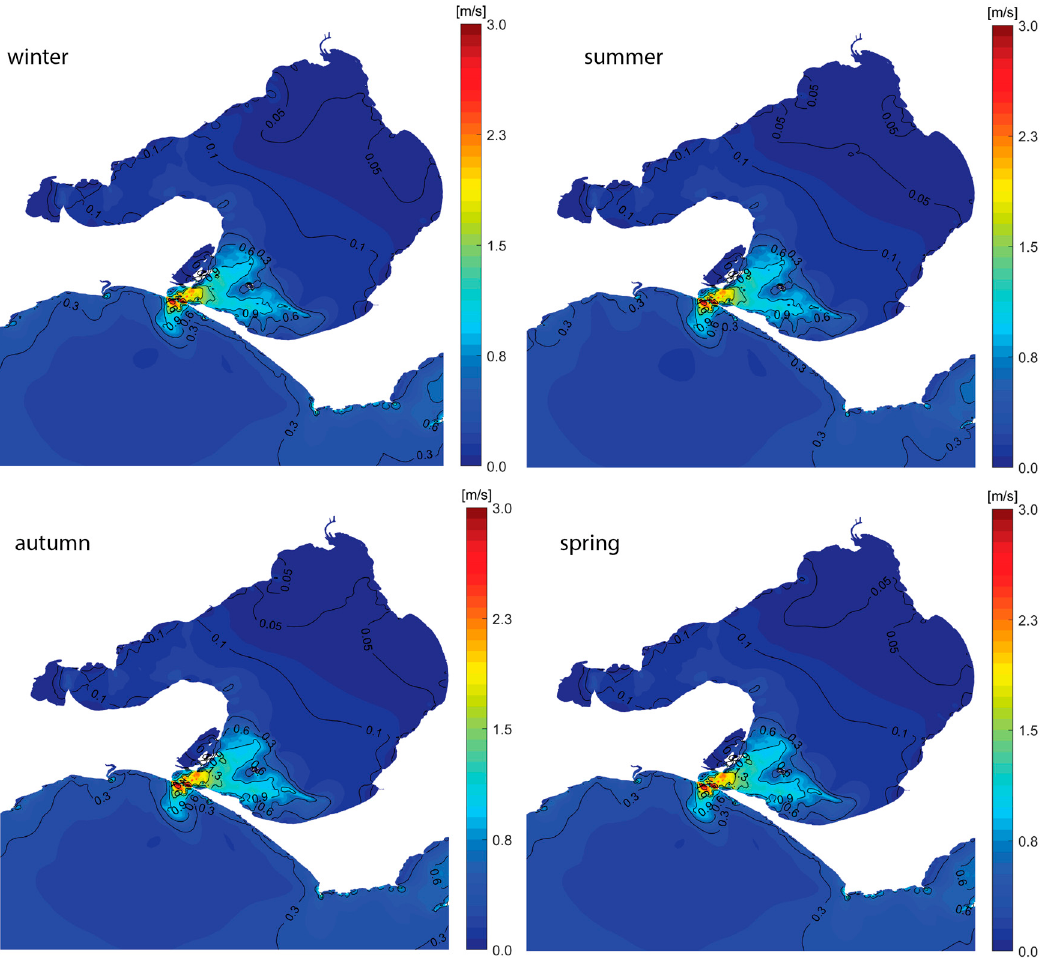
Figure 15. Maps showing the 99th percentile current speed. The magnitude goes beyond 3 m/s in the vicinity of PPH. However, in the inner regions of PPB, the current speed is weak with the magnitude of about 0.1 m/s.